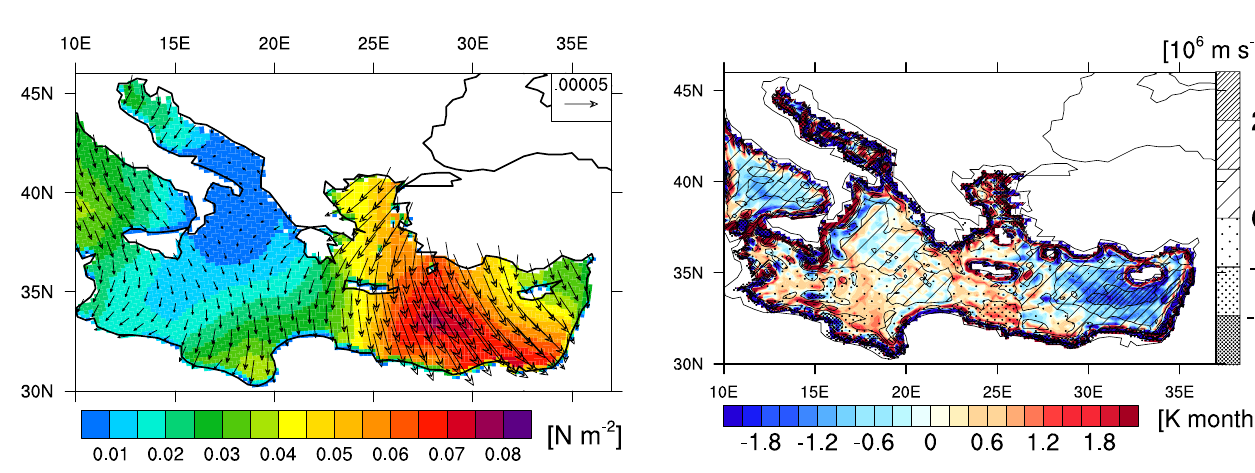
Fig. 14. Mean summer (JAS) wind stress for CTRL.